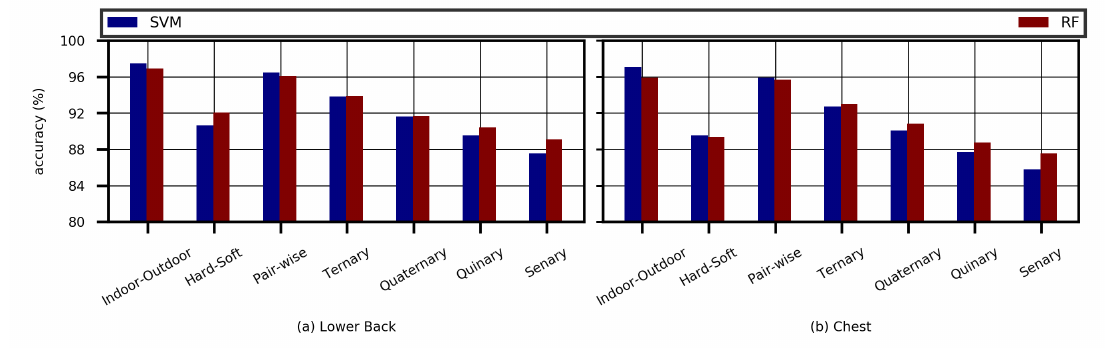
Figure 9. Bar chart showing the comparison of each classifier at each sensor location on different classification